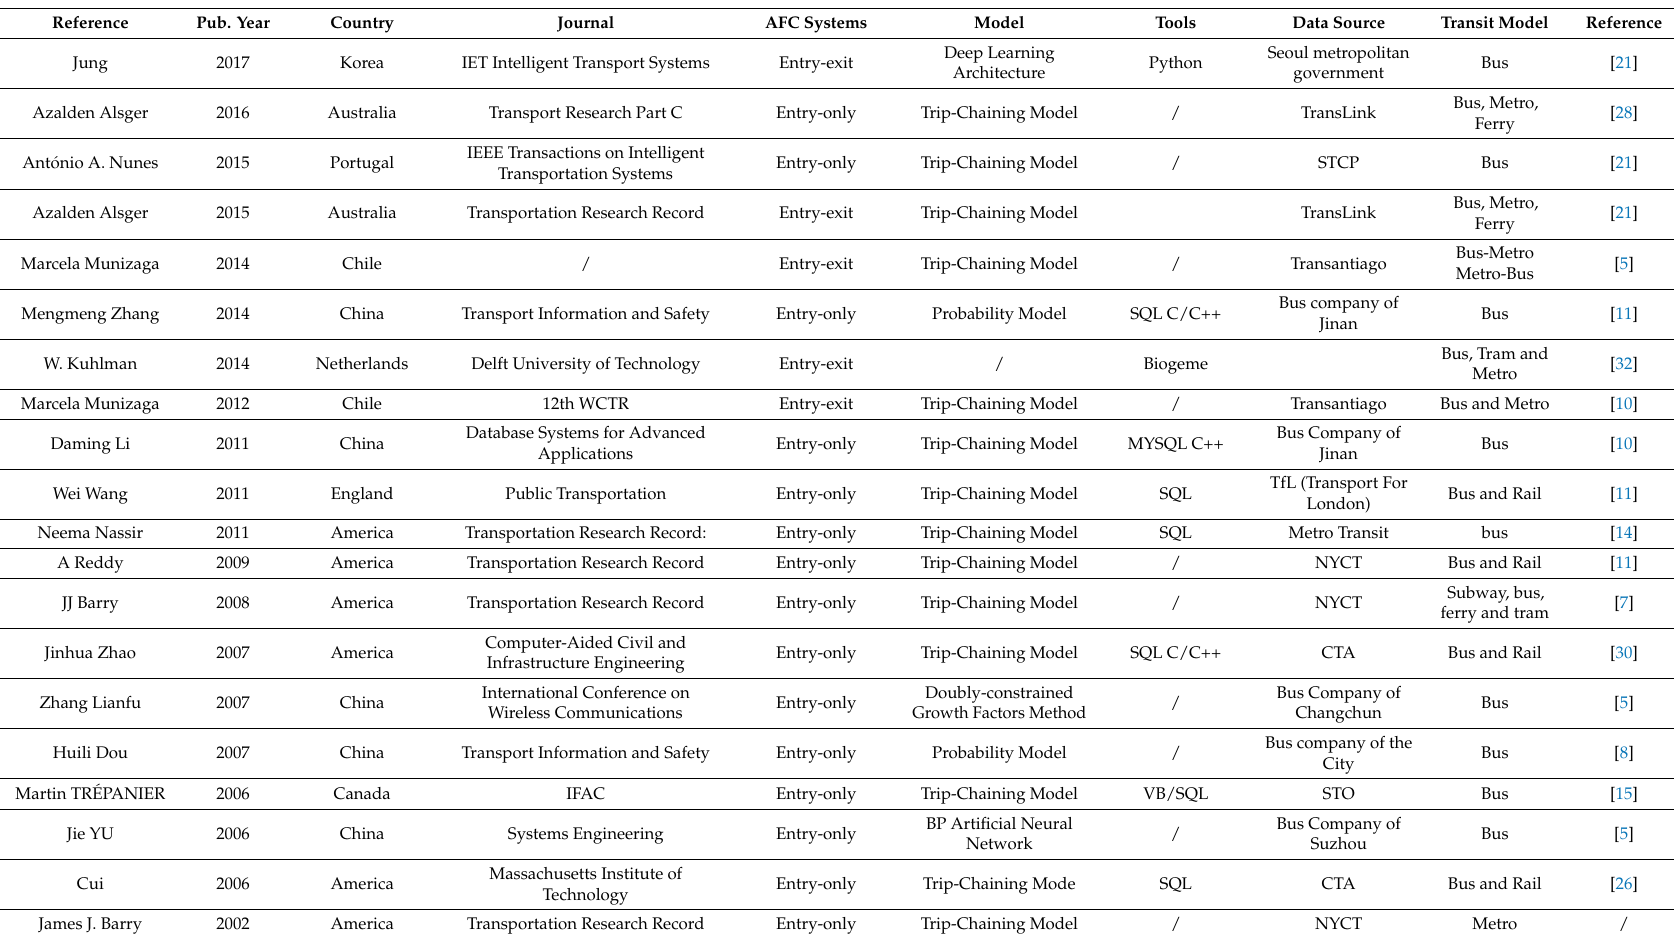
Table 2. Summary of studies included in this